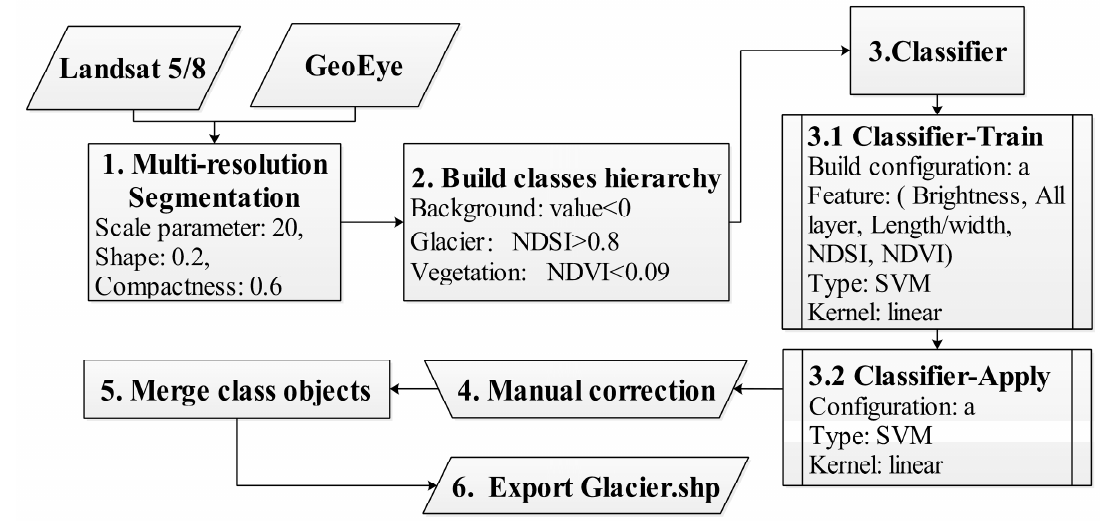
Figure 3. Flowcharts of glacier outline delineation using object-based image classification.